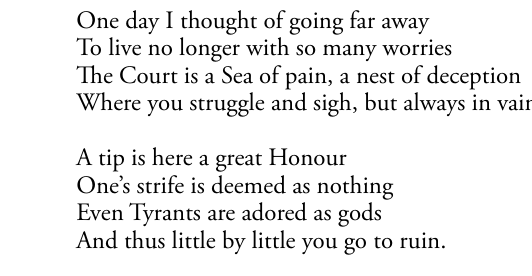
Figure 10 – Graffito ‘Mi venne un di pensier di gir lontano’. Photo by Manuele